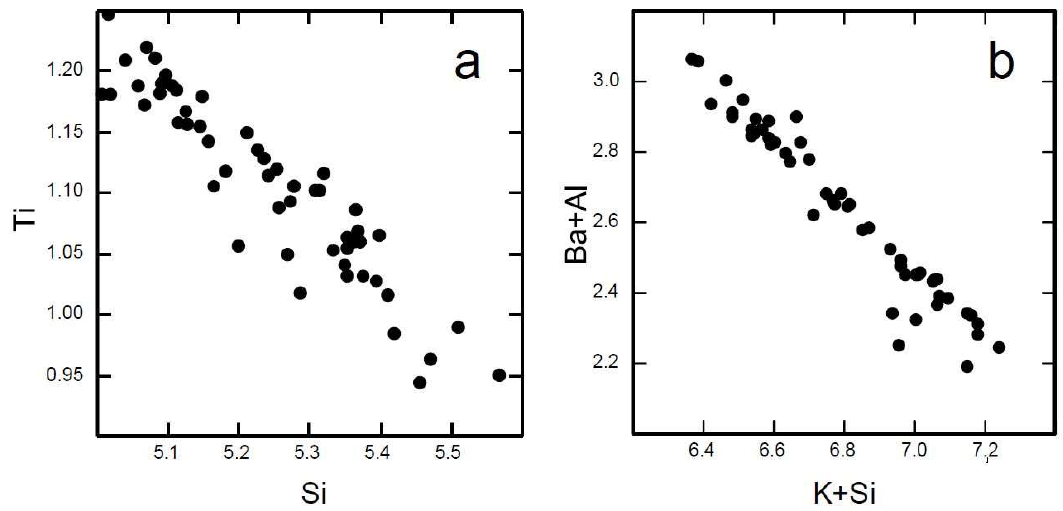
Figure 8. Plots showing the negative correlations between ( a ) Ti 4 + and Si and between ( b ) Ba + Al and K + Si. Data obtained from SEM/EDS analyses.